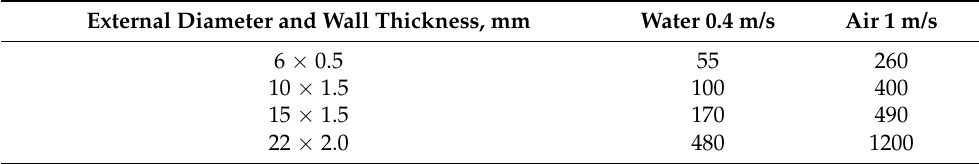
Table 5. The time after which the RTD’s response to a step change in temperature reaches 90% of its maximum value, s. Steel